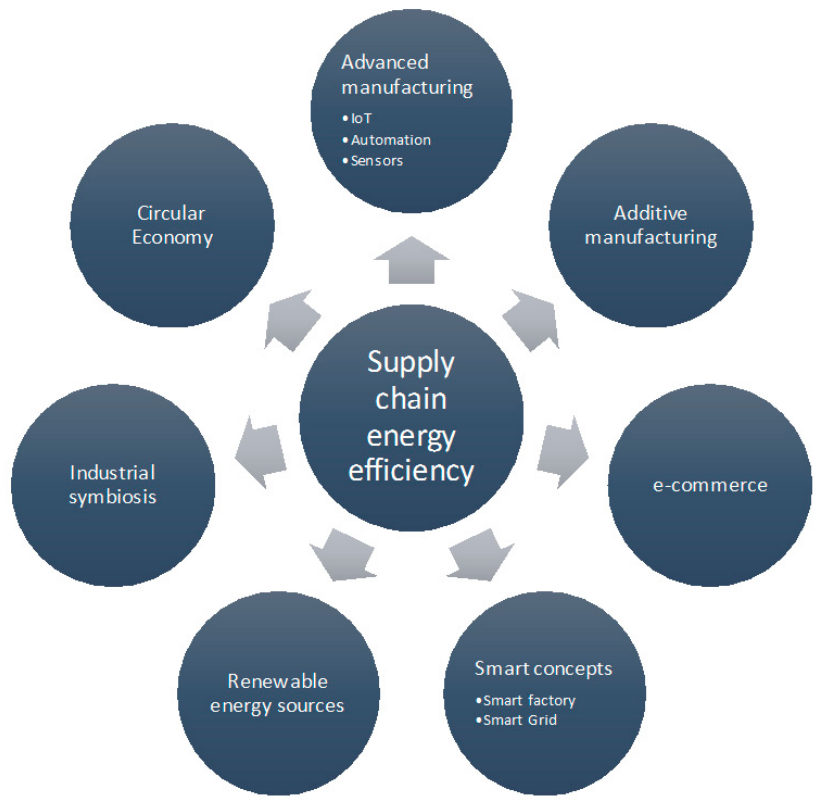
Figure 9. Future research